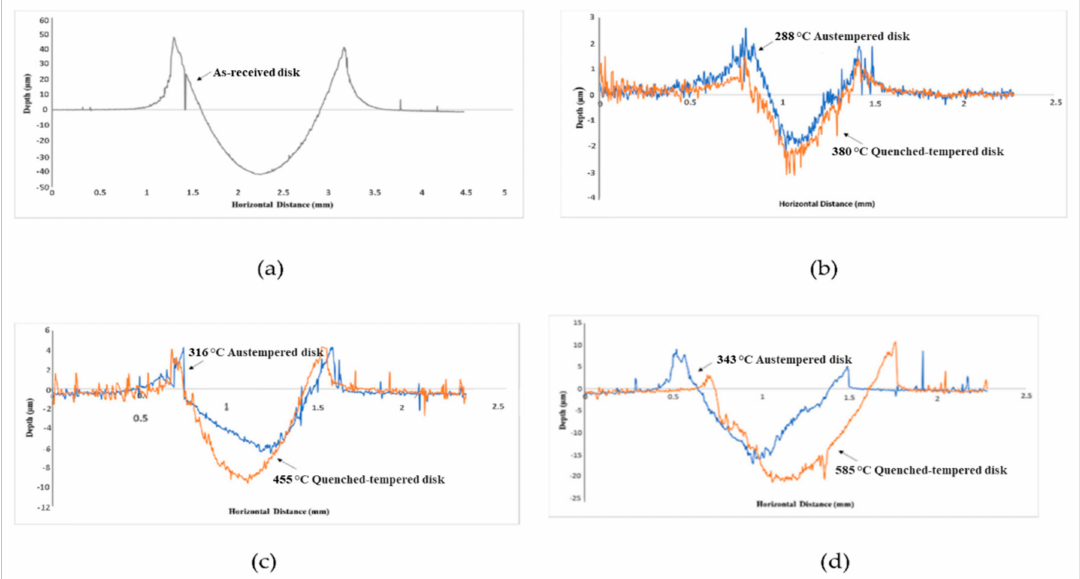
Figure 7. Pile up of: ( a ) as-received disks, ( b ) 288 ◦ C austempered disks versus 380 ◦ C quenched-tempered disks, ( c ) 316 ◦ C austempered disks versus 455 ◦ C quenched-tempered disks, ( d ) 343 ◦ C austempered disks versus 585 ◦ C quenched- tempered